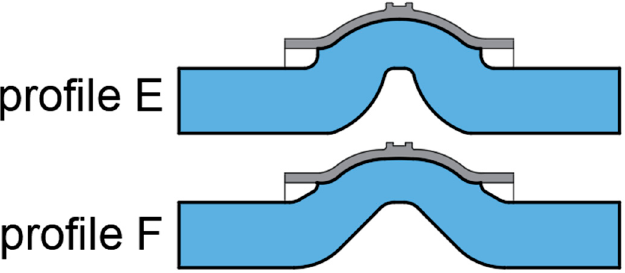
Figure 17. The optimized surface F and the optimized surface E.